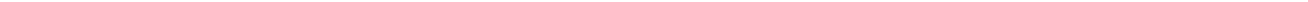
Fig. 2 USP13 and MCL1 are correlatively upregulated in cancer. a Pan-cancer analysis of USP13 and MCL1 genomic alterations in cBioportal database. b Copy number analysis of USP13 and MCL1 in TCGA lung adenocarcinoma, lung squamous cell carcinoma and ovarian serous carcinoma samples. Color scale: ampli fi cation in red and deletion in blue. c Expression of USP13 and MCL1 in human lung cancer and ovarian cancer cell lines. We used 22 lung cancer and 33 ovarian cancer cell lines to determine the endogenous protein levels of USP13 and MCL1. d Representative images for immunohistochemical staining of USP13 and MCL1 protein in human ovarian cancer samples, normal lung and lung cancer tissues (scale bar = 50 µ m). Statistical signi fi cance of correlation between USP13 and MCL1 protein levels was determined by a χ 2 (chi-squared) test. R represented the correlation coef fi cients. e Positive correlation of USP13 with MCL1 protein expression in human ovarian cancer tissues, and enrichment of USP13 or MCL1 expression in human lung cancer specimens relative to normal lung tissues. Forty- fi ve human ovarian cancer samples were categorized into two groups (13 USP13-low and 32 USP13-high), and MCL1 expression status was indicated in each group. Thirty human normal lung or lung cancer tissues were classi fi ed based on the USP13 or MCL